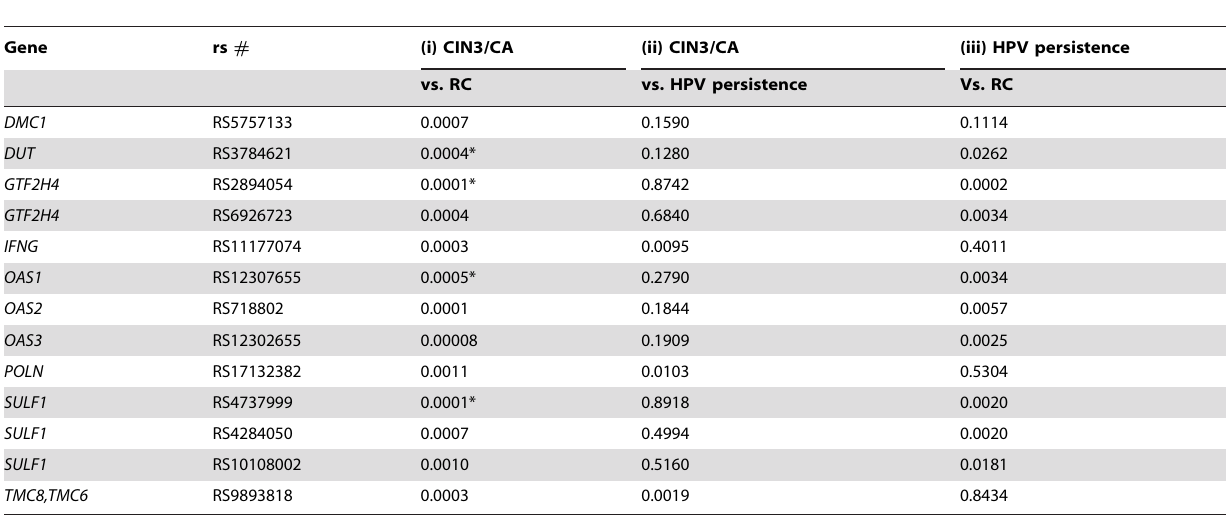
Table 3. Significance levels (p values) for (i) cervical precancer/cancer, (ii) progression to cervical precancer/cancer, and (iii) HPV persistence, among SNPs with p # 0.001 for an association with cervical precancer/cancer.